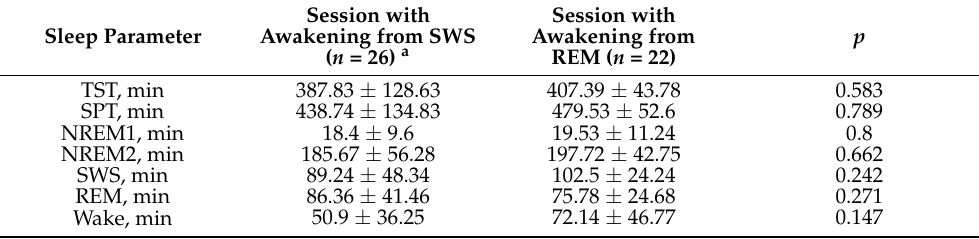
Table A1. Comparison of sleep characteristics in sessions with SWS and REM awakenings. Sleep